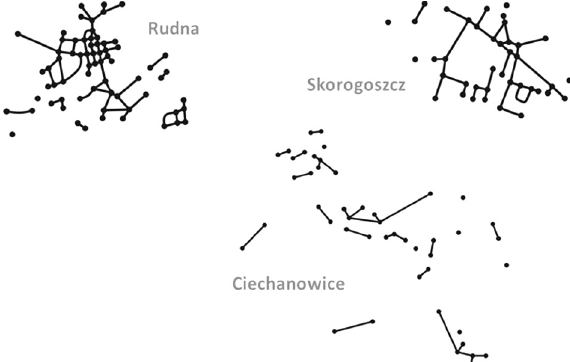
Fig. 7. Graphs depicting the morphology of historical towns (HT1-HT2). Source: own work.